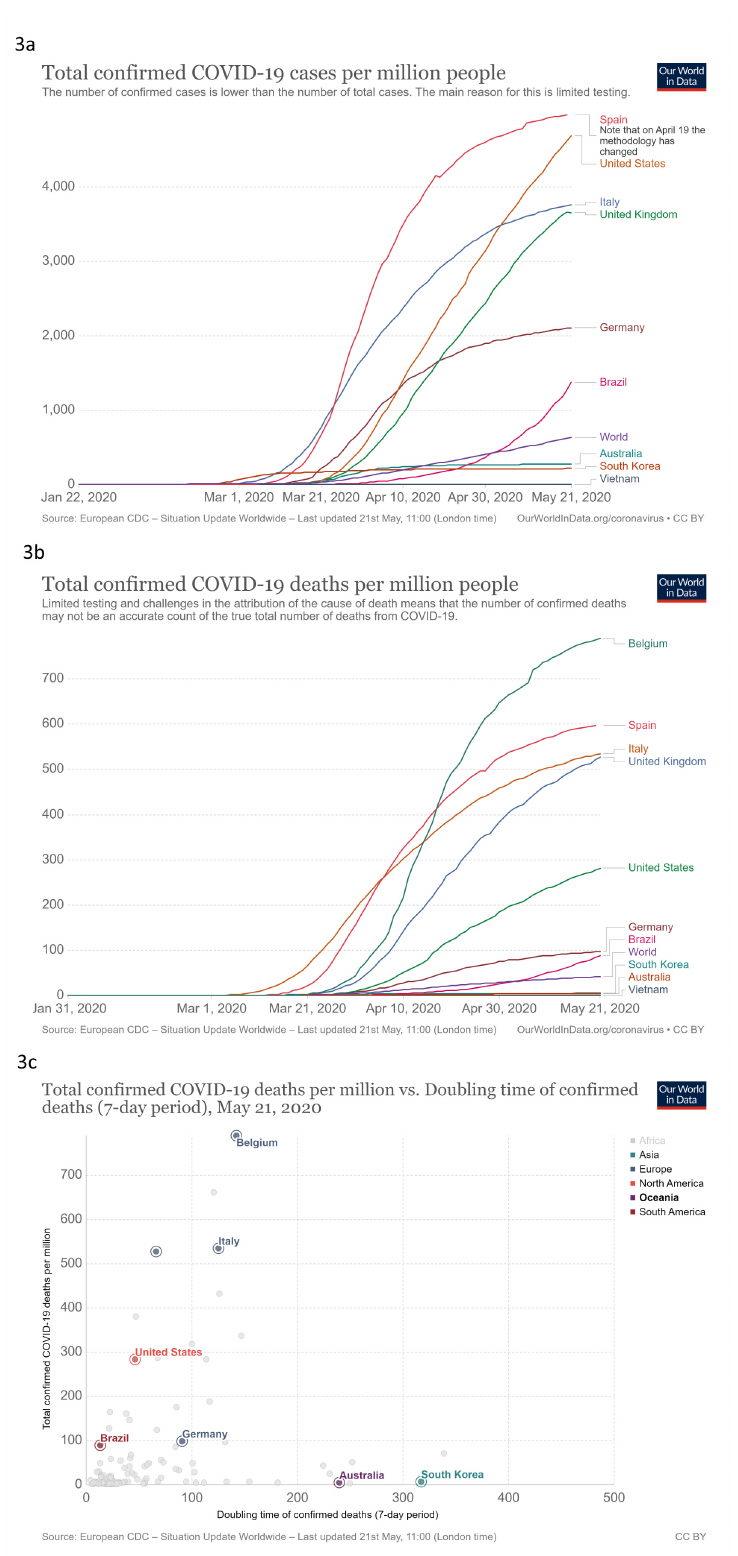
Figure 3. Contain. These graphs show a ) total confirmed COVID-19 cases per million people b ) total confirmed COVID-19 cases per million people compared to doubling time of total confirmed cases (7-day period) c ) total confirmed COVID-19 deaths per million people against time d ) total confirmed COVID-19 deaths per million compared to doubling time of confirmed deaths (7-day period). Updated graphs can be found here, here, here and